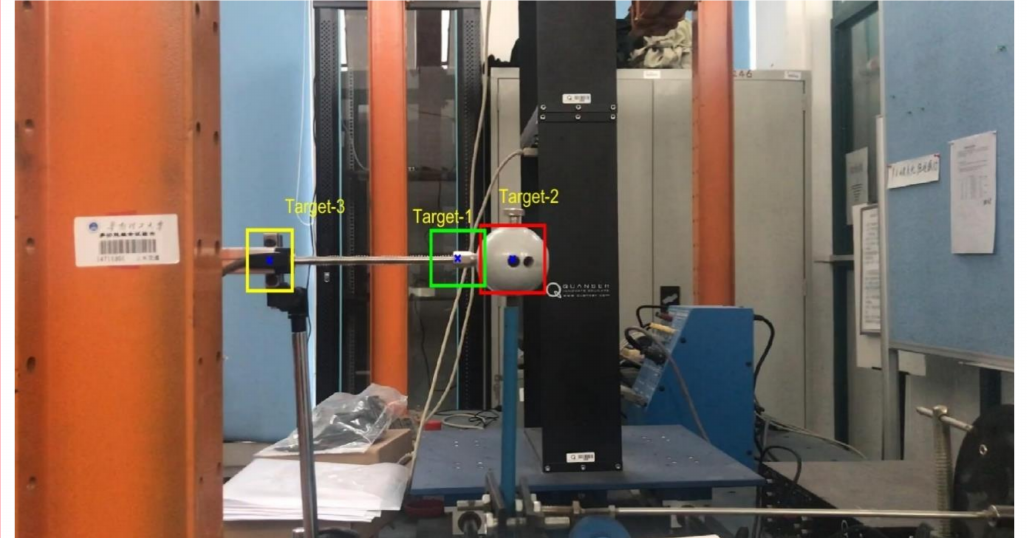
Figure 13. Initial definition of three tracking